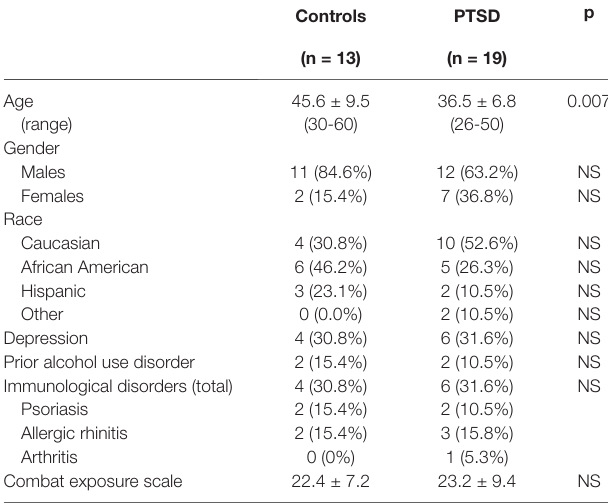
TABLE 1 | Descriptive information on research